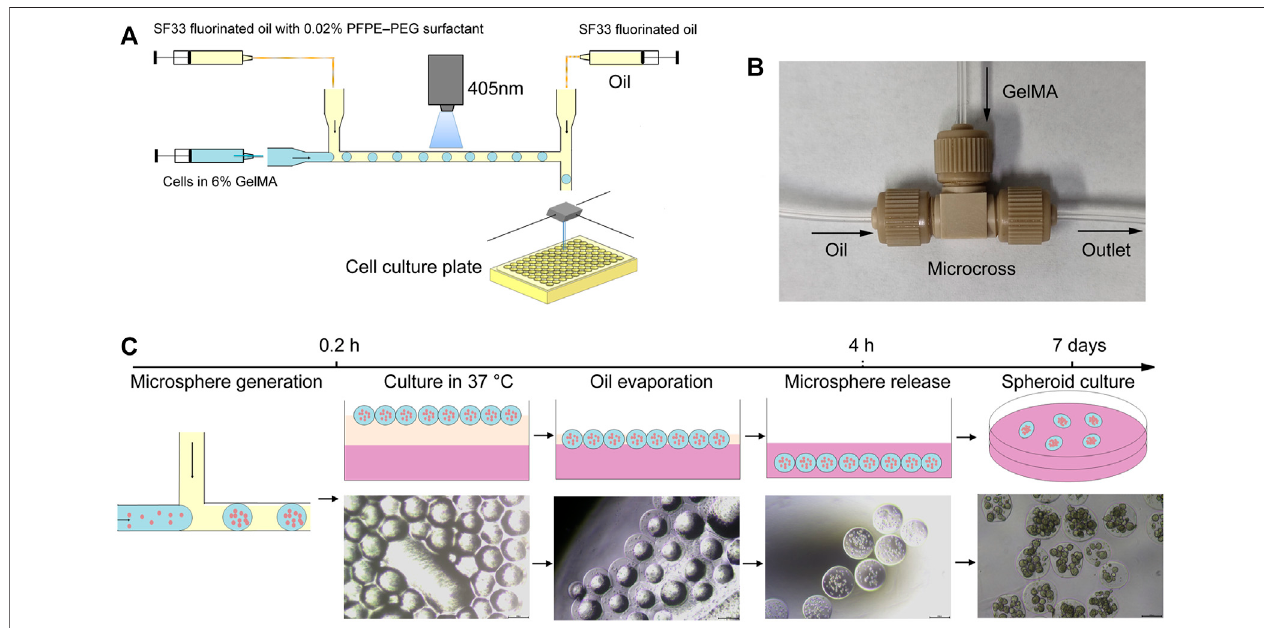
FIGURE 1 | Schematic illustration of the developed micro fl uidic system for one-step hydrogel microsphere generation. (A) Schematic diagram of the micro fl uidic platform. (B) Con fi guration of the micro fl uidic chip. (C) Generation and separation procedures for obtaining hydrogel microspheres.